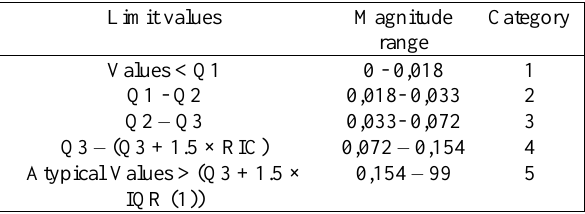
Table 2. Categorization according to change magnitude.